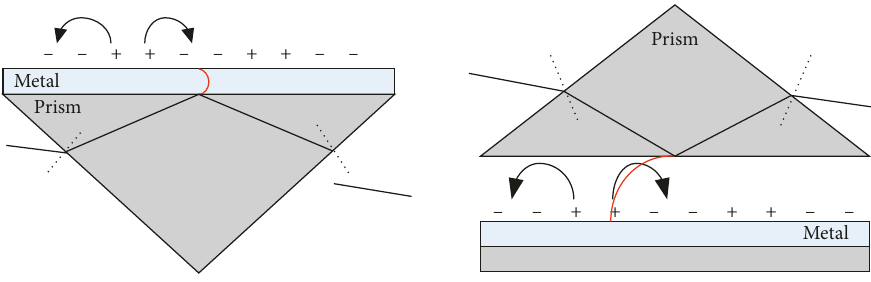
Figure 3: Linearly excited surface plasmon